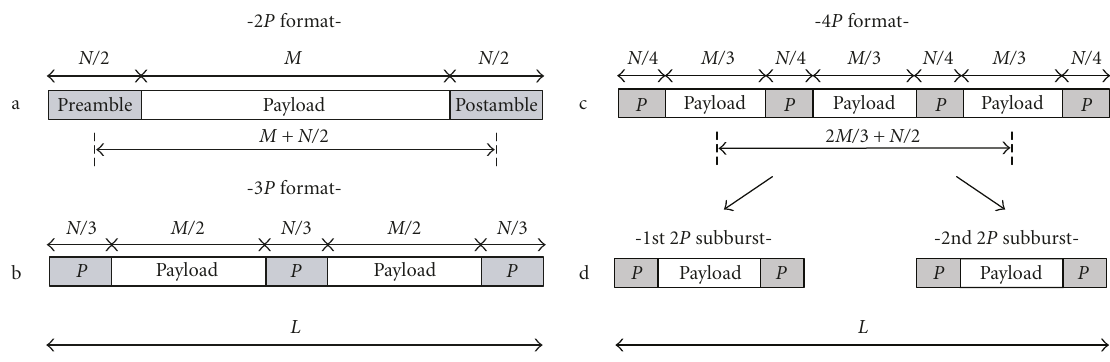
Figure 1: 2 P burst format, 3 P burst format, and 4 P burst